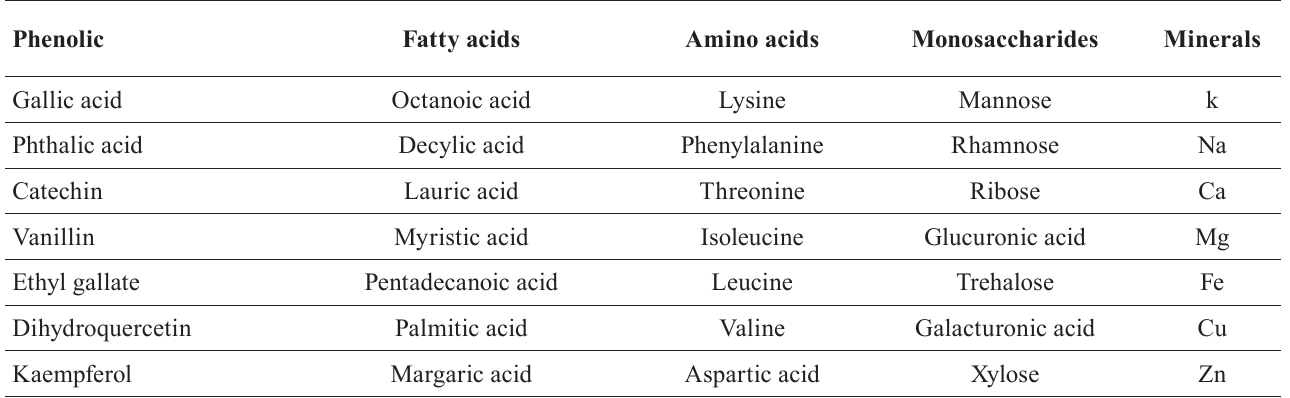
TABLE I - C hemical compositions and nutritional attributes of